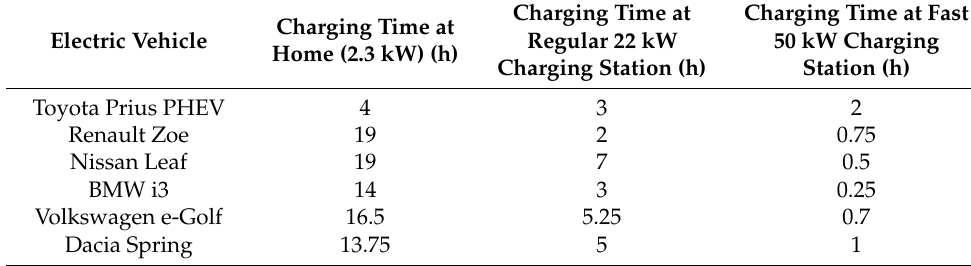
Table 6. Charging time of